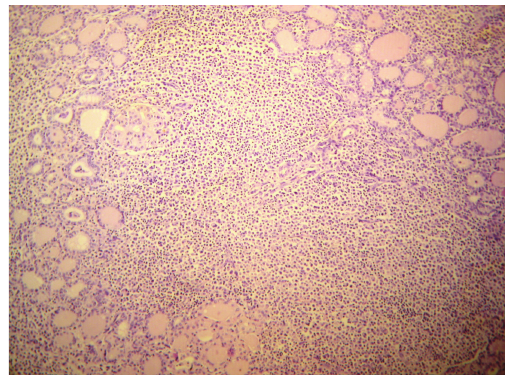
Figure 2: Histopathology slide showing atypical lymphoid cells, which originate within the marginal zone of the lymphoid follicles.